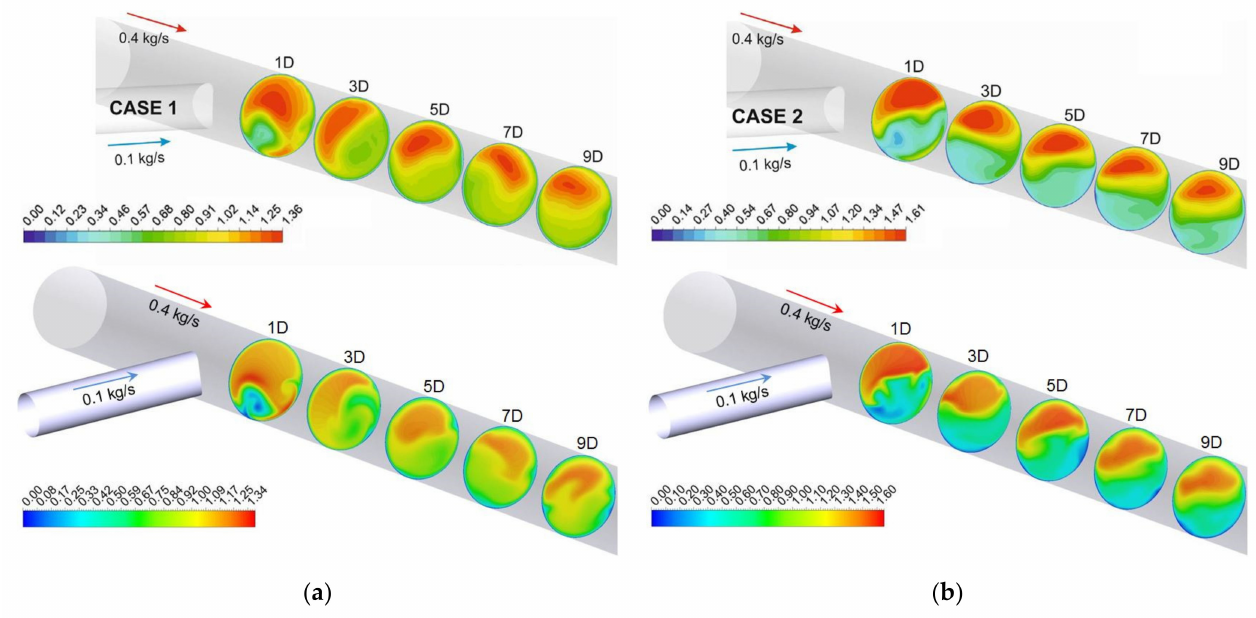
Figure 13. Distribution of the dimensionless velocity U * in different sections downstream behind the mixing zone: ( a )—ST1, Table 2 (top figure—LES results [12], bottom figure—RANS results); ( b )—ST2, Table 2 (top figure—LES results [12], bottom figure—RANS results).